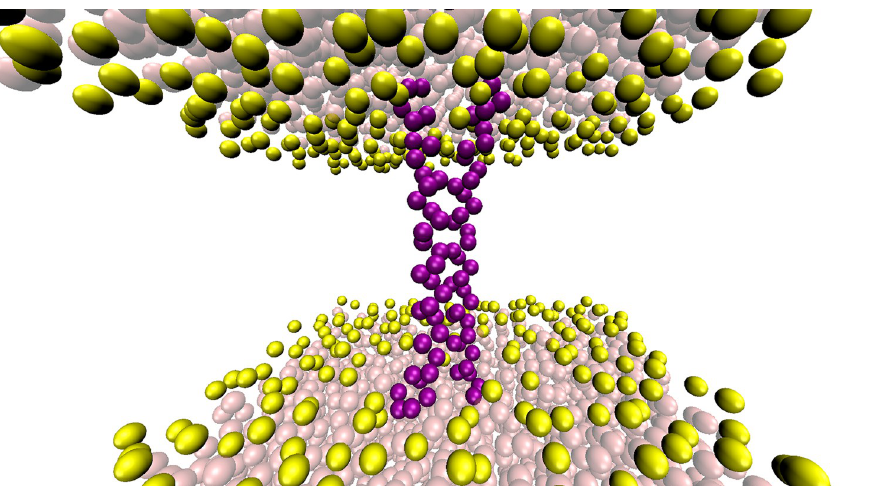
Fig 2. The structure of the initial system used in CG MD simulations. TM helix dimer buried in lipid bilayer is shown in purple. The CG beads of phosphate and choline groups of POPC lipid bilayer are shown in yellow. Standard MARTINI water particles are shown as transparent